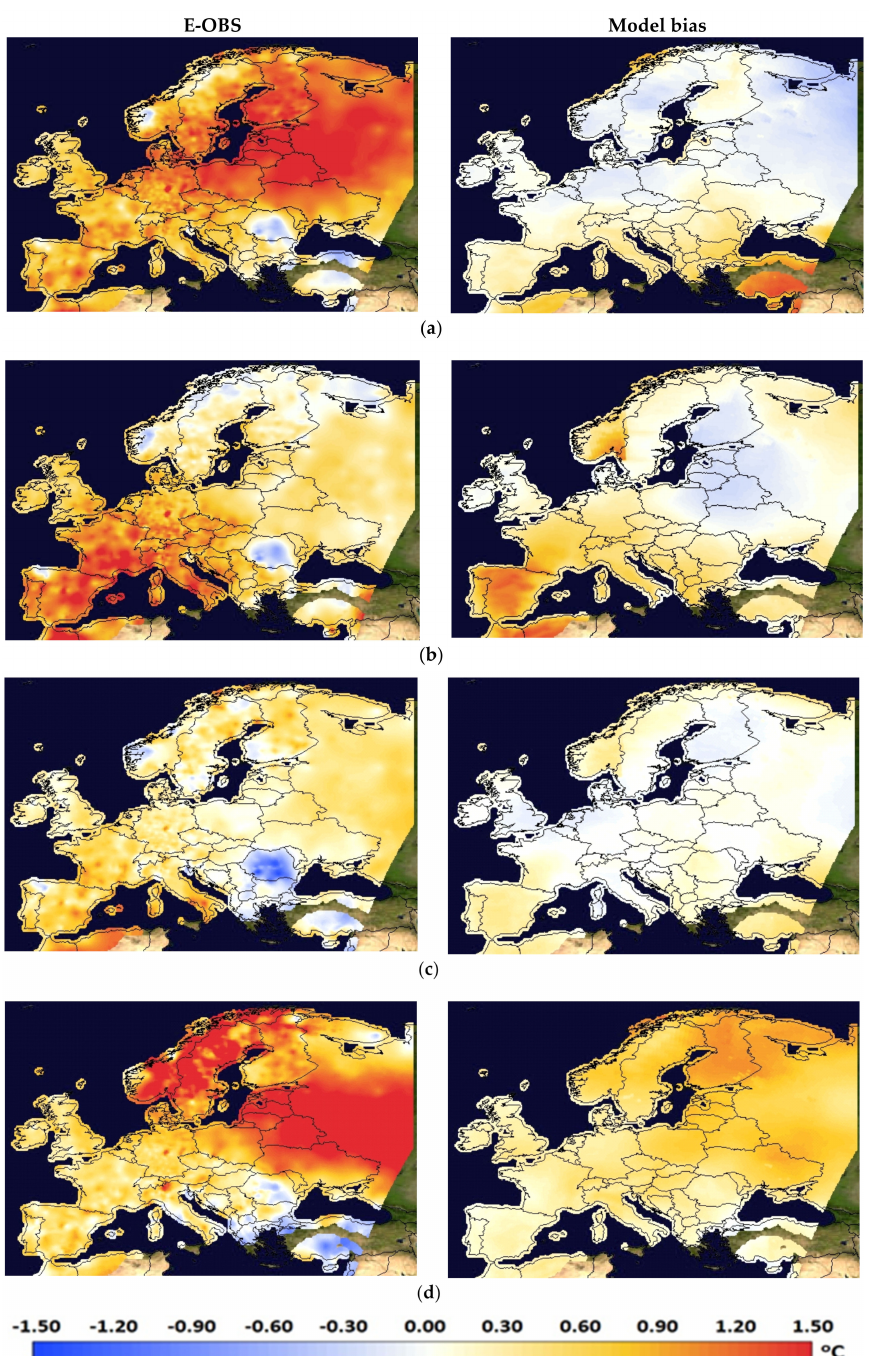
Figure 3. Seasonal mean surface temperature changes observed (E-OBS, left panels) and the related model biases (E-OBS—Model, right panels) between current and historic periods for ( a ) spring (MAM), ( b ) summer (JJA), ( c ) autumn (SON), and ( d ) winter